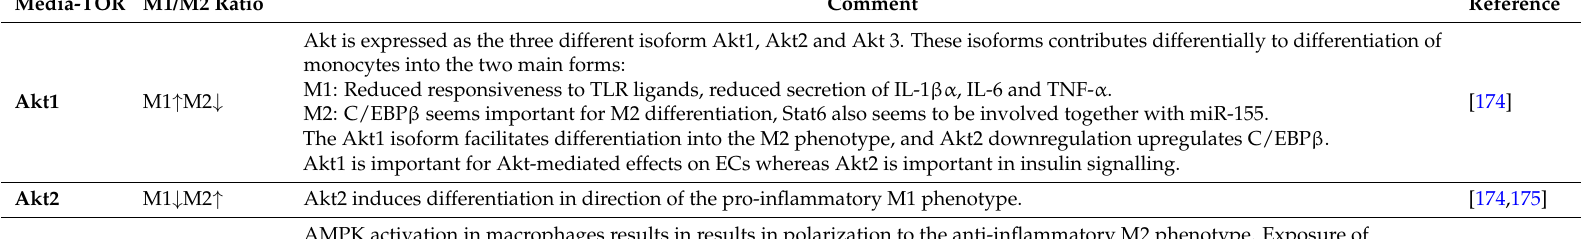
Table 6. Effects on monocyte differentiation of knocking out single mediators involved in PI3K-Akt-mTOR signalling; the results from animal knockout models. Media-TOR M1/M2